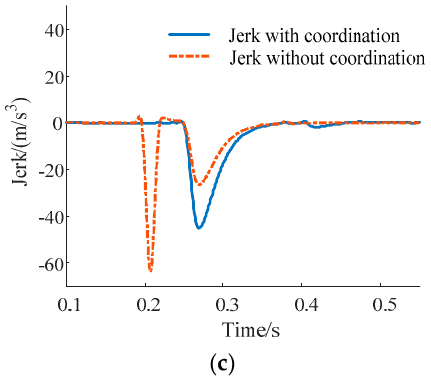
Figure 13. Simulation results of motor braking mode to motor and hydraulic braking mode. ( a ) Total braking torque; ( b ) Motor and hydraulic braking torque; ( c ) Vehicle jerk.